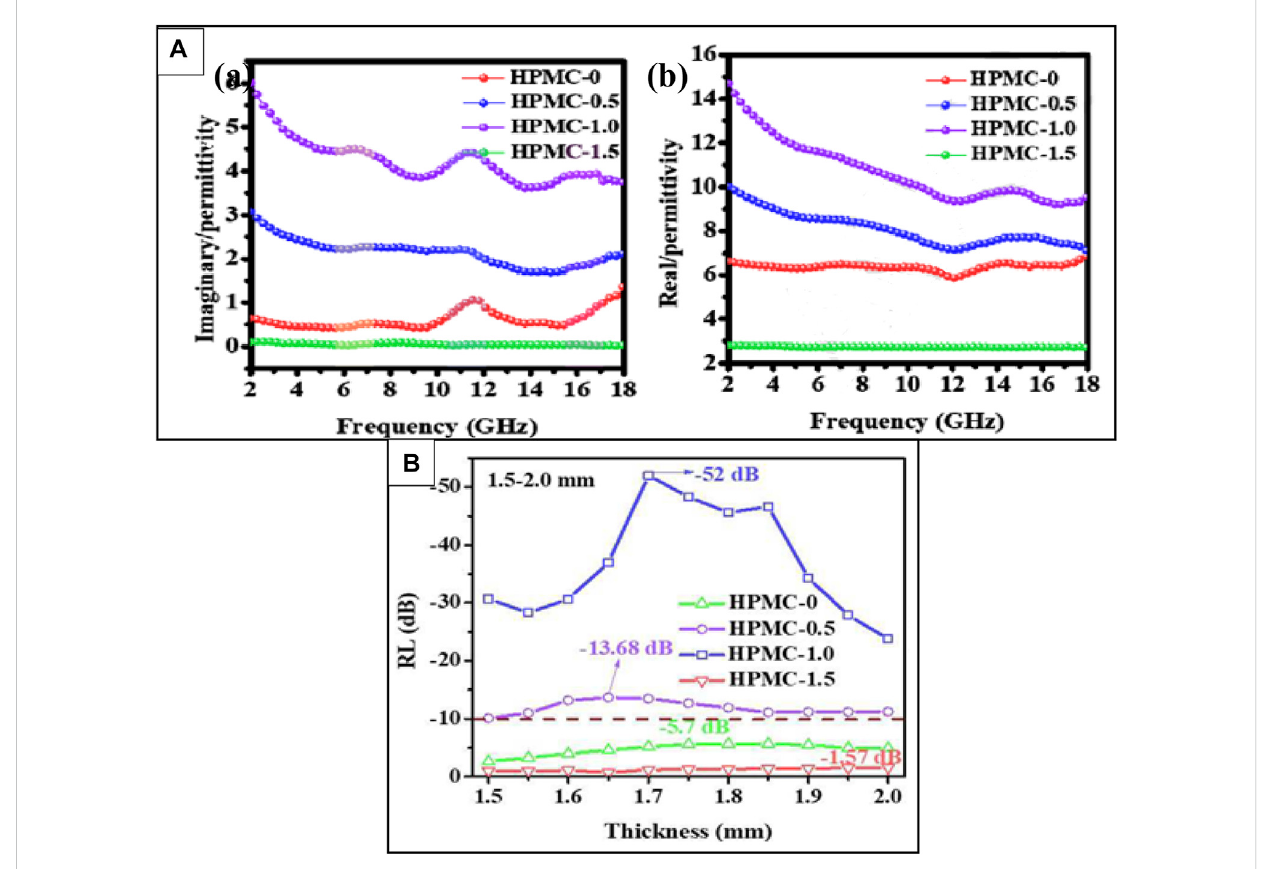
FIGURE 9 (Aa,b) Factors of permittivity and (B) RL values within 1.5 – 2.0 mm for all samples (Zhao et al.,